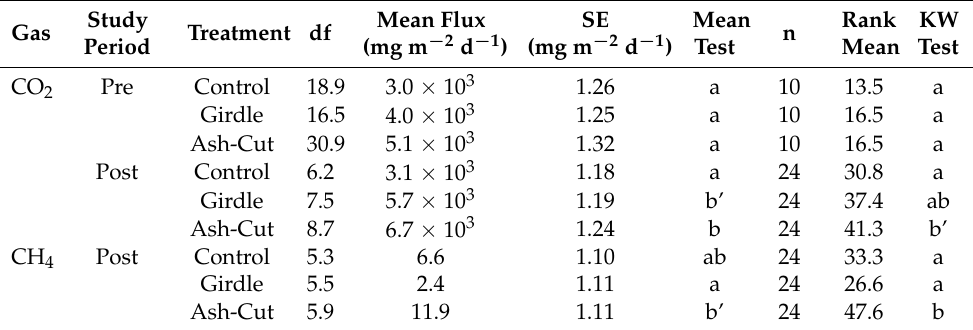
Table 2. Summary statistics, including degree of freedom (df), standard error (SE), Tukey honest significant difference (Mean Test), and Kruskal–Wallis rank means comparisons (KW Test), for each soil gas (CO 2 and CH 4 ), study period (pre- and posttreatment), and